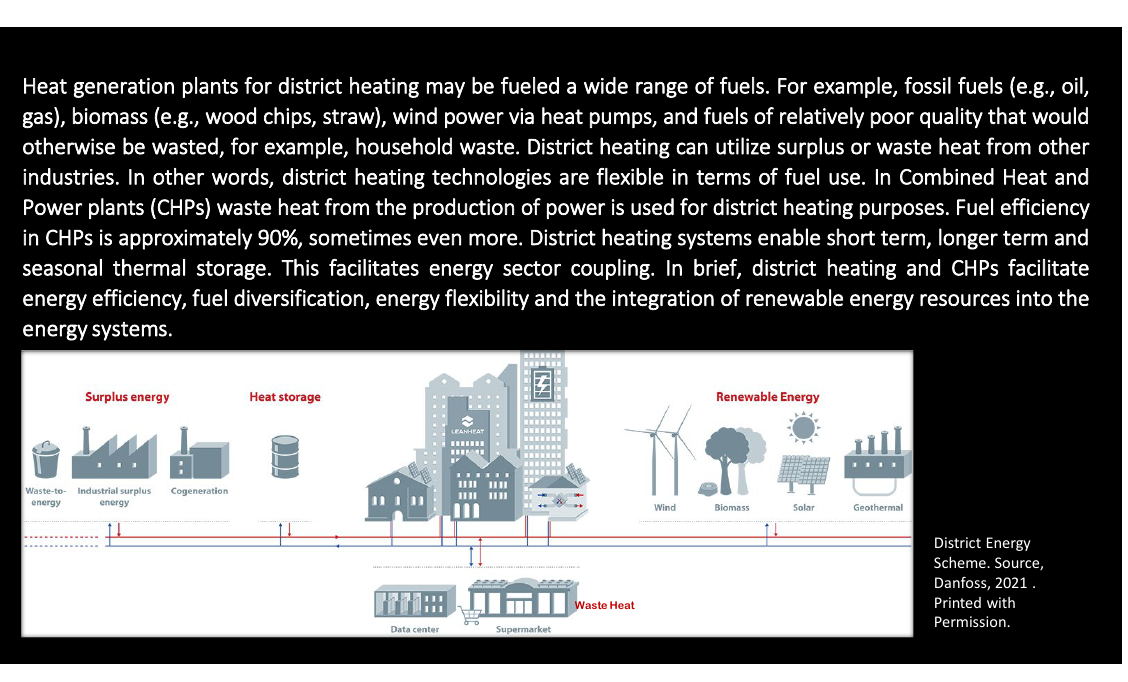
Figure 1. District energy/the integrated energy system. Sources [7,10,12,26].